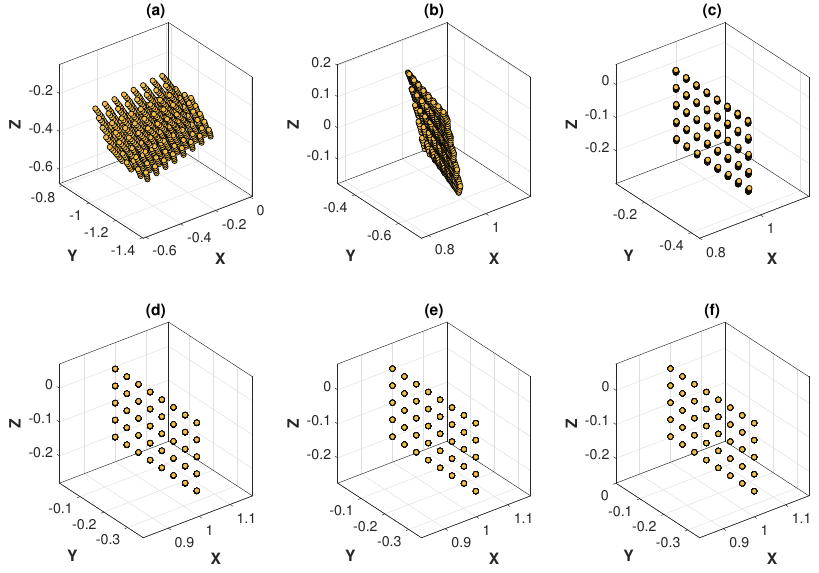
Figure 13. Optimization process of the MinVar method with feature noise [0–0.15 pixel]: ( a ) 3D points at iteration 1; ( b ) 3D points at iteration 6; ( c ) 3D points at iteration 10; ( d ) 3D points at iteration 13; ( e ) 3D points at iteration 16; ( f ) 3D points at iteration 27